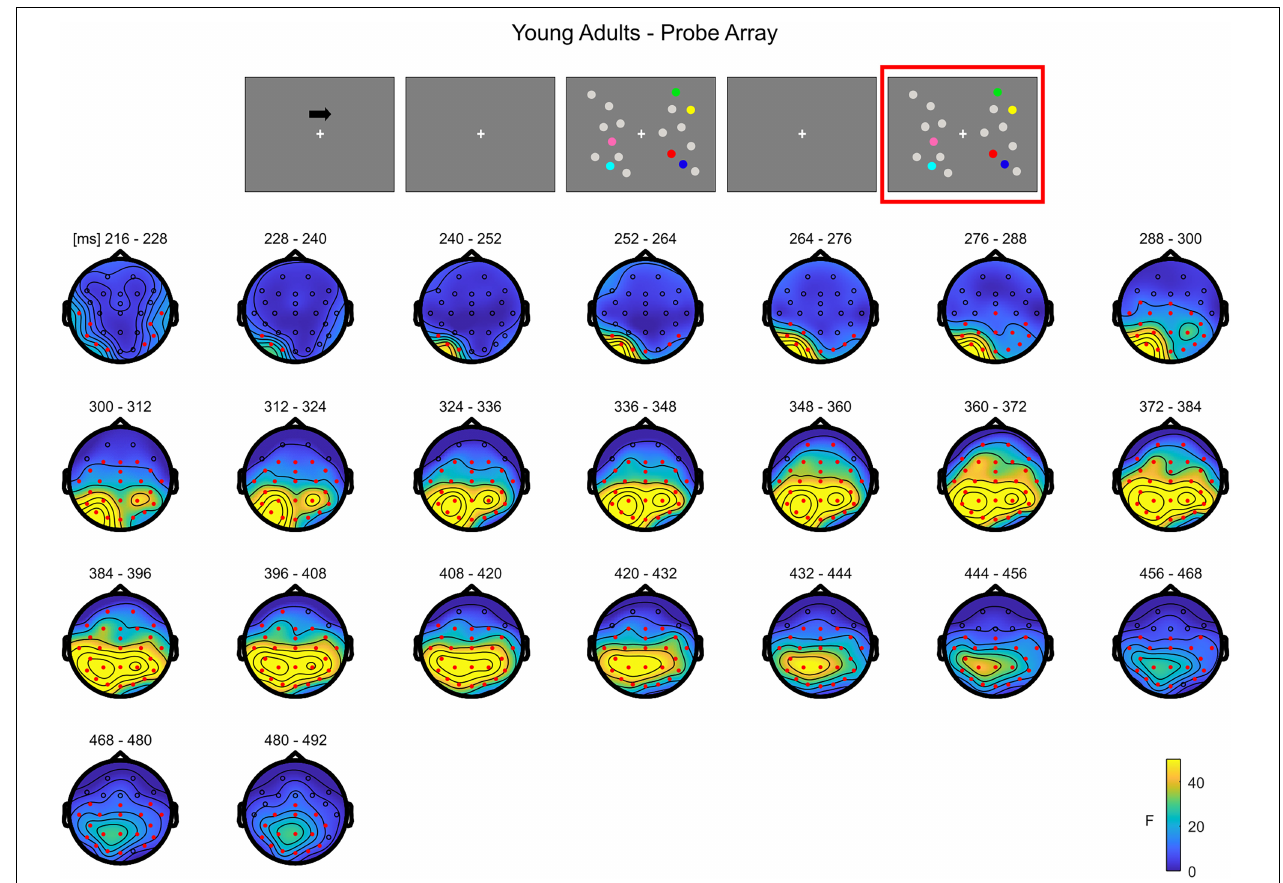
FIGURE 7 | Cluster-based permutation ANOVA results during item comparison in the Younger group. The spatio-temporal evolution of the significant Load effect is represented through topographical maps of the clusters averaged in bins of 12 ms. Only significant time windows are depicted (for the complete time course, see Supplementary Figure 4 ). Red dots represent the significant effect. The color bar represents the range of F -values. Left and right channels are set as contralateral and ipsilateral to targets,